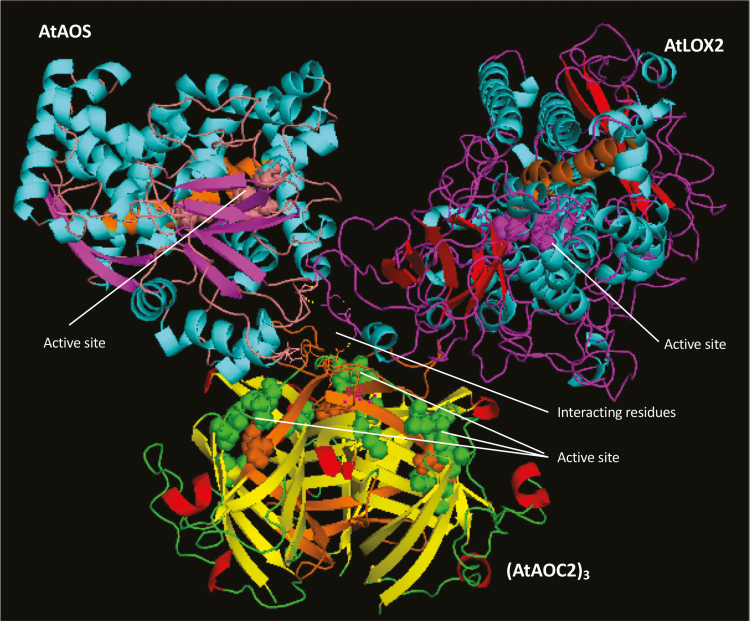
Structural model of the LOX2-AOS-(AOC2)3 interaction in the chloroplast inner envelope. The transmembrane domain is shown in orange. Active sites are shown with spheres and interacting residues with lines. Active site predictions for LOX2 are based on Youn et al. (2006), for AOS2 on Lee et al. (2008), and for AOC2 on Hofmann et al. (2006), and transmembrane domain predications are based on TMpred for LOX2 and (AOC2)3.